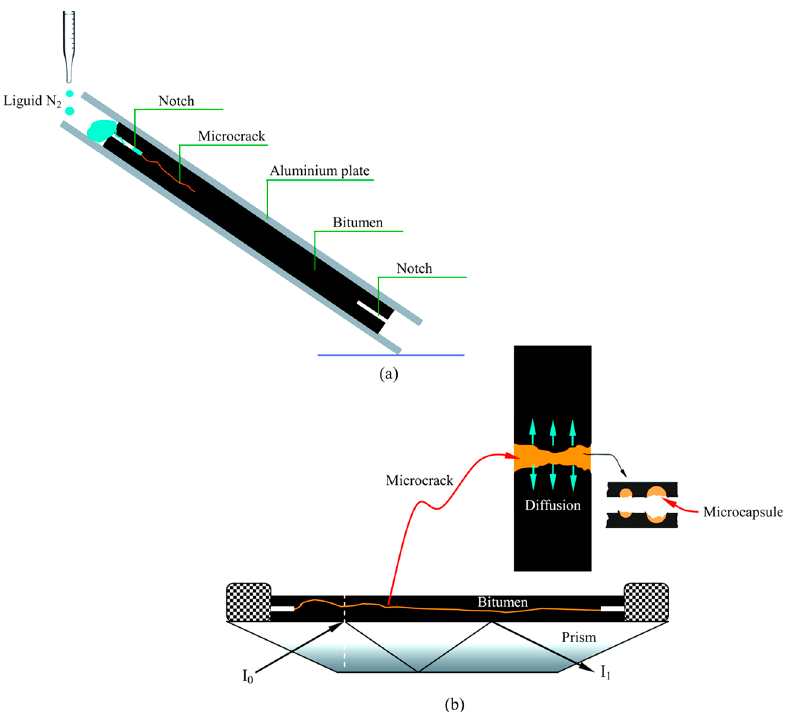
Figure 2. The illustration of FTIR-ATR method testing the diffusion behavior of rejuvenator in bitumen, ( a ) the aluminum plate containing bitumen with notch ends, microcrack generated by liquid N 2 ; ( b ) the FTIR-ATR testing prism.